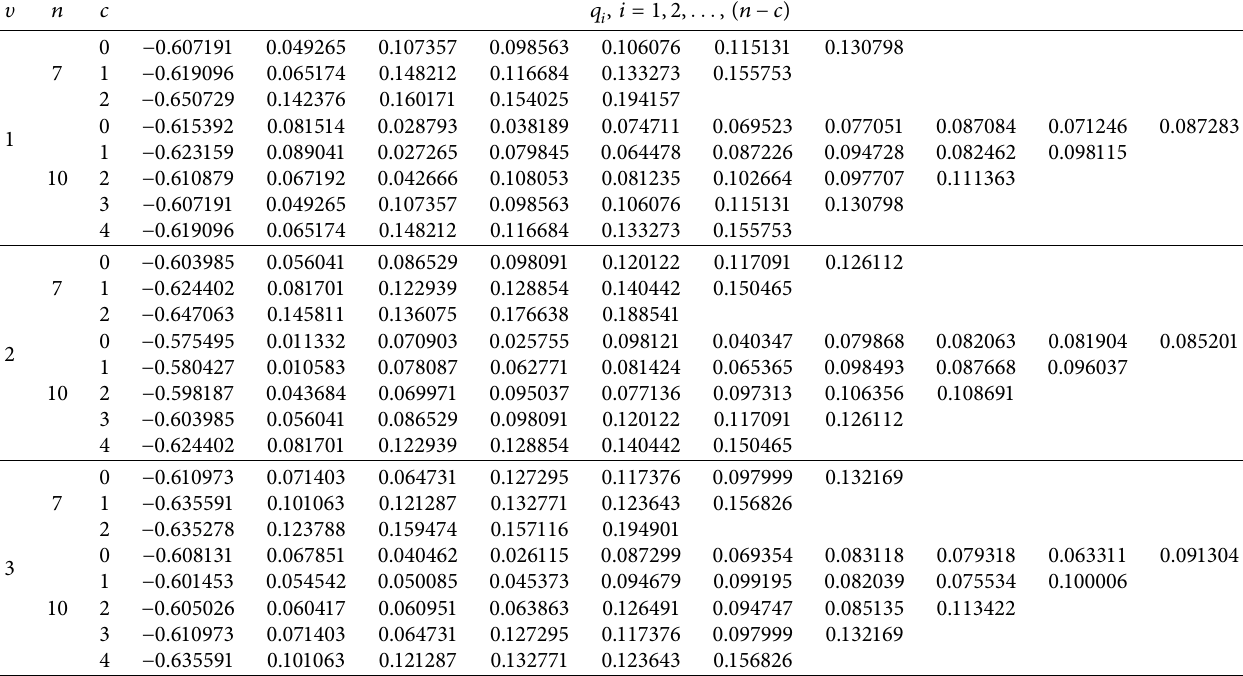
Table 2: Coefficients of the BLUEs of the scale